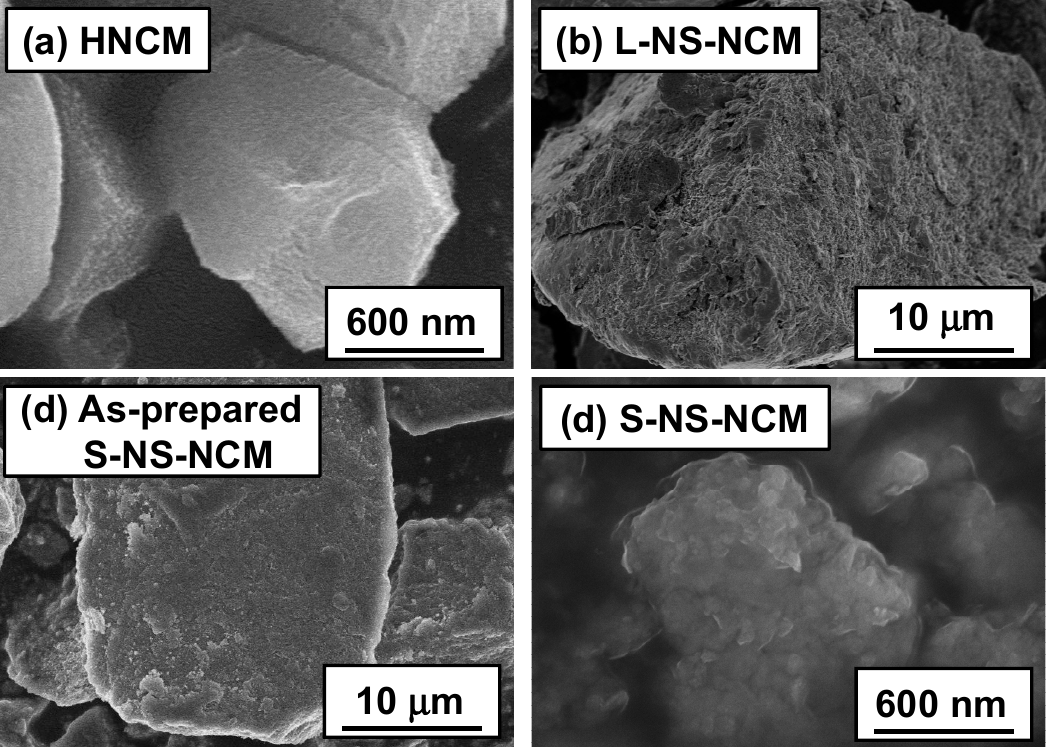
Figure 3. SEM images of ( a ) HNCM; ( b ) L-NS-NCM; ( c ) as-prepared S-NS-NCM; and ( d ) S-NS-NCM.